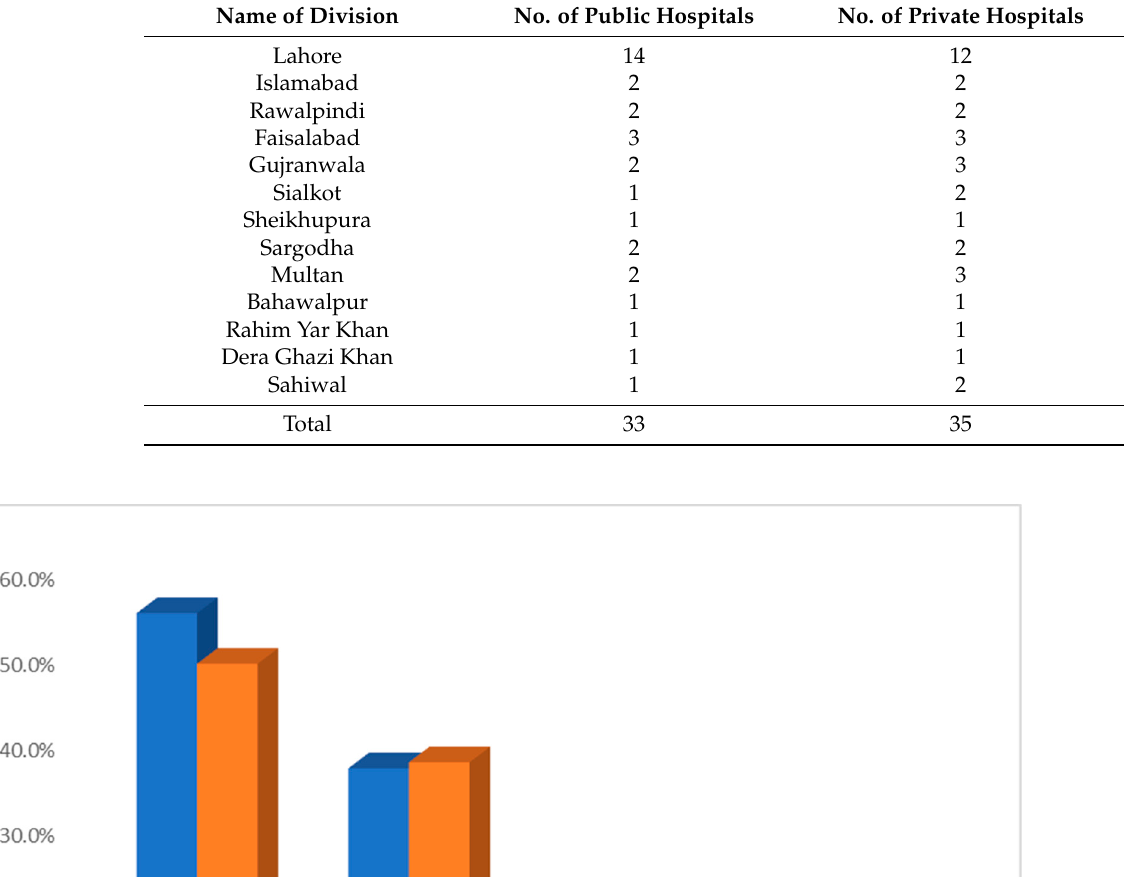
Table 1. Number of public and private hospitals that participated from each division of Punjab.